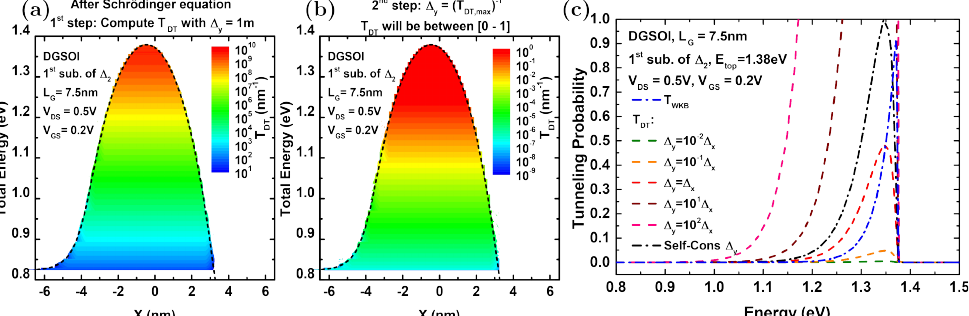
Figure 3. Example of the procedure that restores self-consistency in the MS-EMC simulation by means of T DT by defining a suitable value for ∆ y that also works as a normalization factor for the probability. ( a ) After solving the Schrödinger equation in each time step, we computed T DT ( E x ) taking ∆ y = 1 m. ( b ) We took the maximum of this initial estimation of T DT and defined ∆ y as its inverse, which led to T DT probabilities between 0 and 1. ( c ) We plotted T DT as a function of the total energy considering different choices of ∆ y (self-consistent and dependent on ∆ x